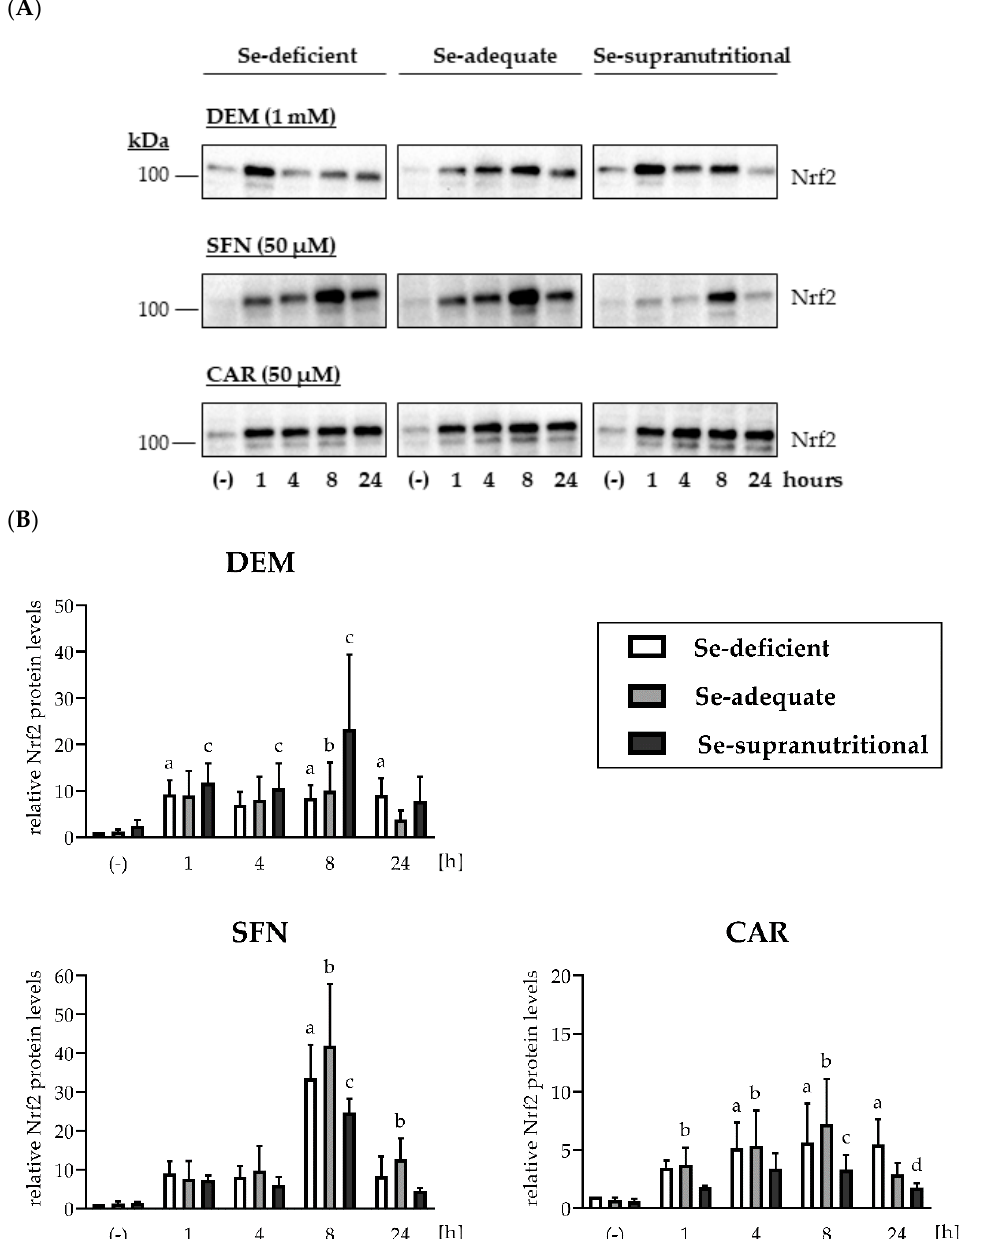
Figure 2. Induction of Nrf2 upon exposure of HepG2 cells to electrophiles. Cells were cultured for 16 h in serum-free medium without added Se (Se-deficient) or containing 0.1 µ M selenite (Se-adequate) or 1 µ M selenite (Se-supranutritional). Thereafter, the cells were cultured for the indicated time in serum-free medium with the three different Se levels and 1 mM DEM, 50 µM SFN, or 50 µM CAR, respectively. As solvent control, the cells were treated for 1 h with 0.1% DMSO (the lanes for the solvent control were marked with (-)). Nrf2 protein levels were detected by immunoblotting after cell lysis with RIPA buffer. ( A ) Each blot is representative of three independent experiments. ( B ) Relative Nrf2 protein levels as assessed by densitometric analysis of the immunoblots normalized against Ponceau S-stained protein bands; the data represent means ± S.E.M. Statistical analysis was done using the Friedman test and Dunn post hoc test, with statistical significance at p < 0.05: (a) significantly different from Se-deficient solvent control, (b) significantly different from Se-adequate solvent control, (c) significantly different from Se-supranutritional solvent control, (d) significantly different from Se-deficient CAR (24